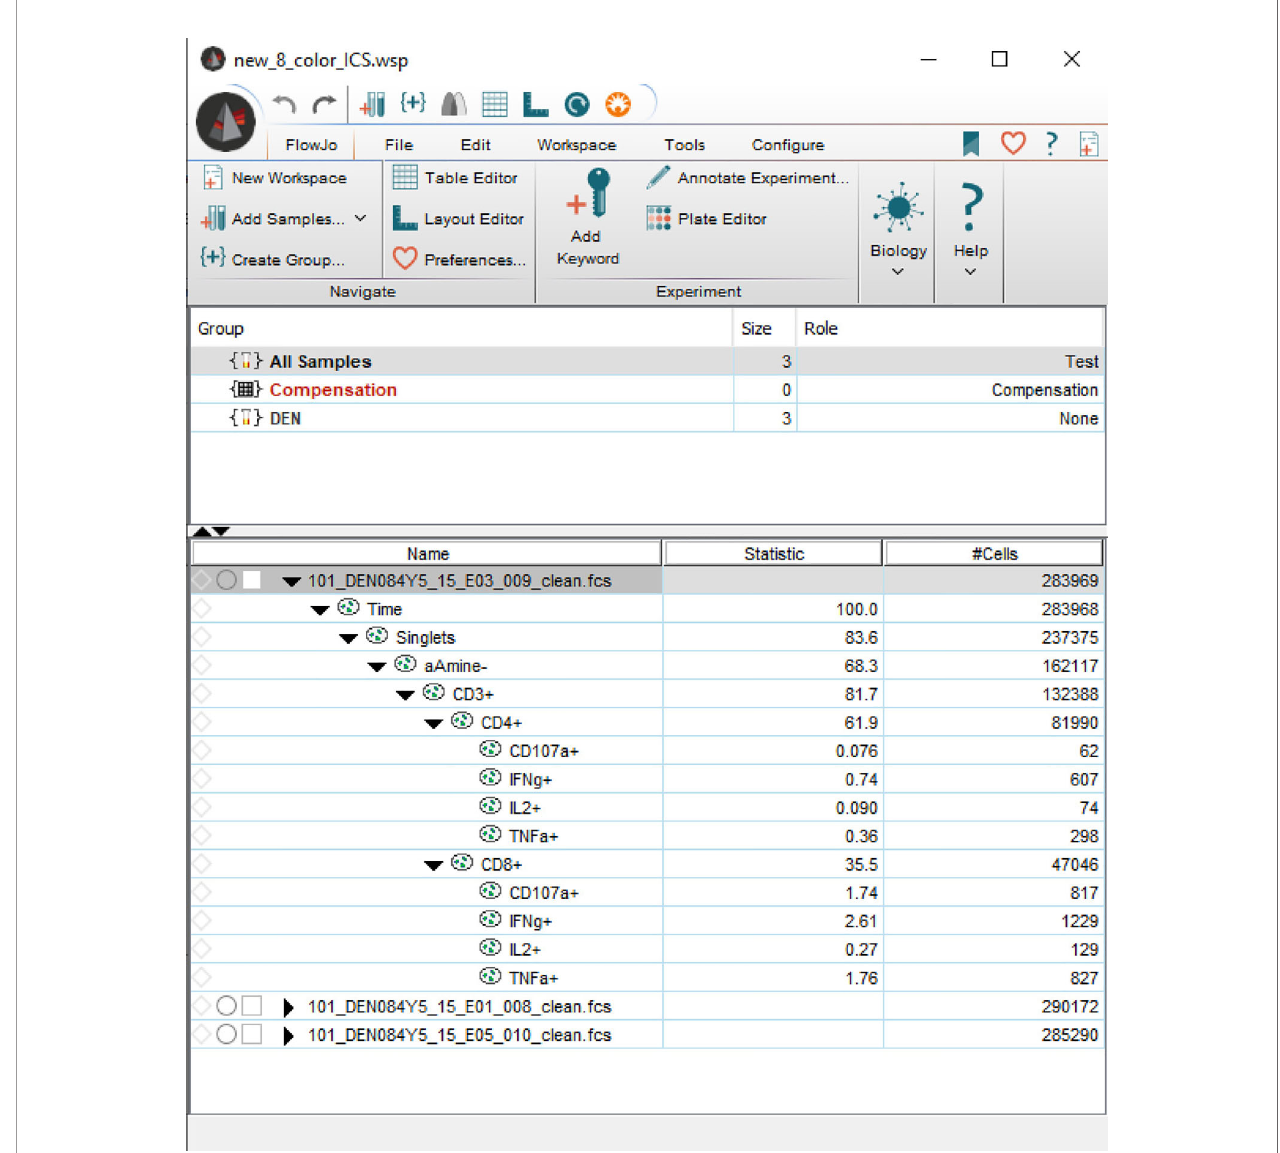
FIGURE 5 | Screenshot taken from FlowJo, showing an imported workspace that is entirely programmatically